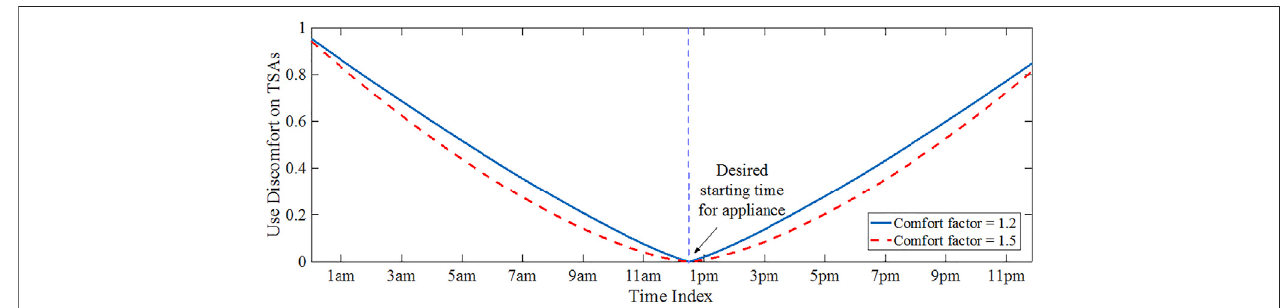
FIGURE 4 | Illustration of the occupant ’ s varying dissatisfaction degree on the operation of a TSA (settings: T (cid:2) 144, Δ t (cid:2) 10minutes t tsa , p i (cid:2) 1pm, and d tsa i (cid:2) 40minutes).